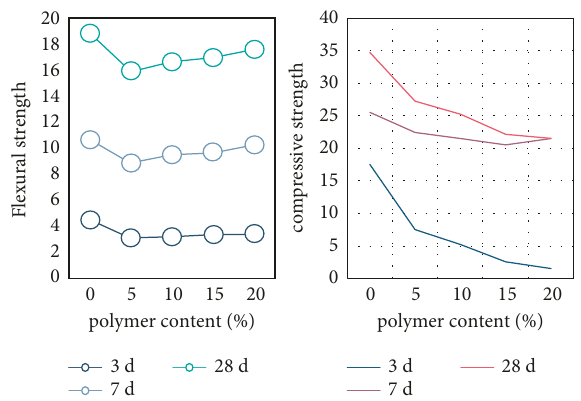
Figure 3: Effect of polymer content on flexural and compressive strength of bonded